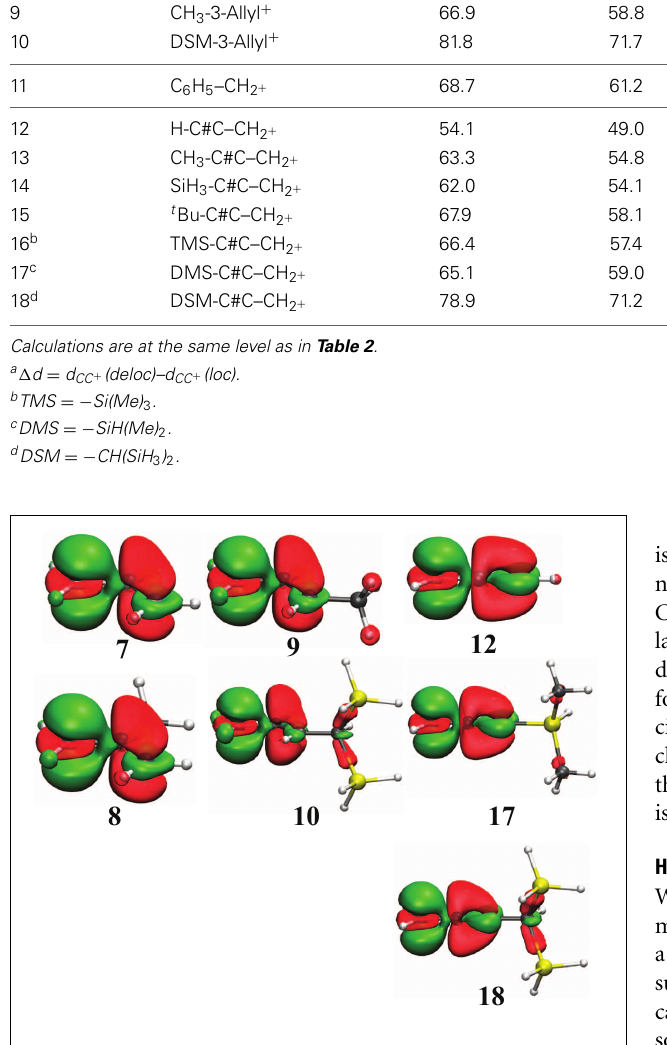
FIGURE 4 | Electron Density Difference map (EDD) of key conjugated carbocations from Table 3. In green is the electron gain, and in translucent red is the electron loss. An isodensity of 4 · 10 − 3 was used